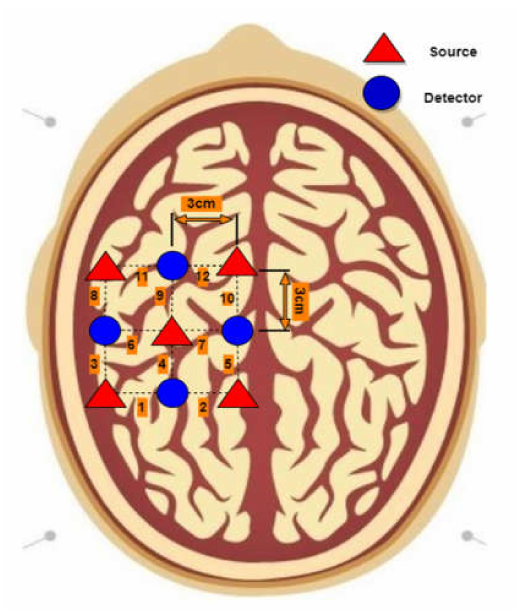
Figure 4. Optode placement on the left hemisphere of the motor cortex with channel configuration using 10–20 international